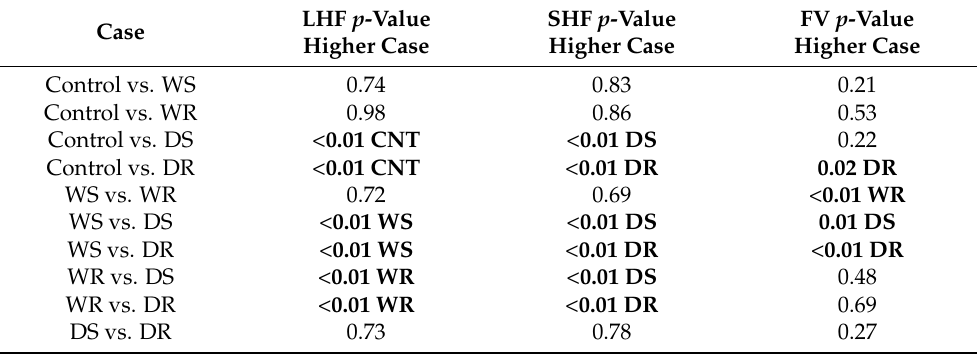
Table 4. Results of pairwise comparisons of cases for TBS daytime hours. Bold signifies p -value < 0.05 and those cells include the case with the higher median value of the